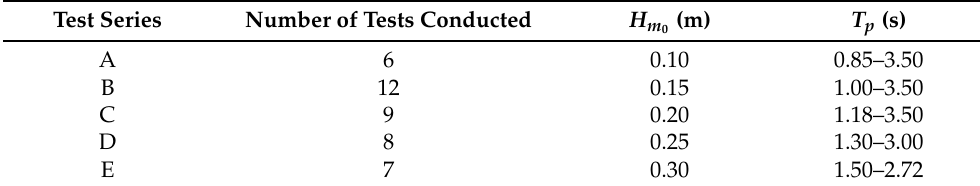
Table 1. List of the wave conditions tested in the LIC